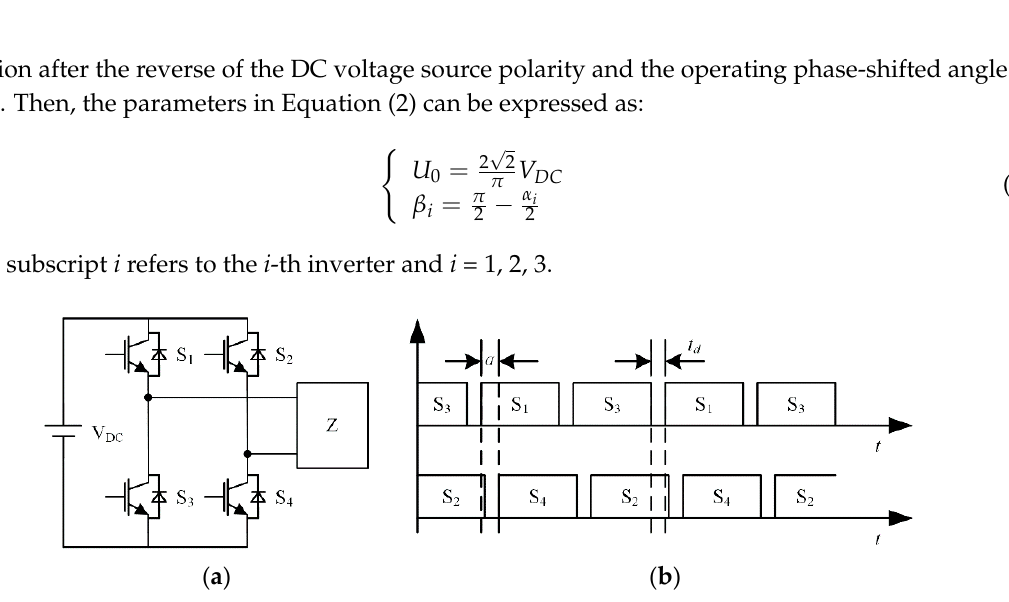
Figure 3. A typical topology of the excitation power source: ( a ) the topology of inverter; ( b ) the drive pulses of power switches.